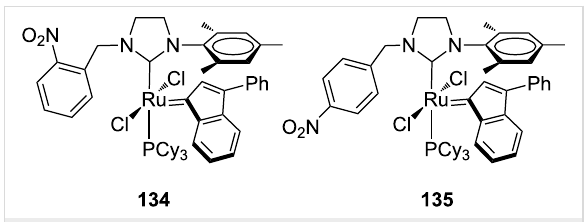
catalysts 120 , 121 , 123 and 124 . A scarce activity toward the formation of tetrasubstituted olefin 12 (Scheme 3) was also ob- served. Complexes 134 and 135 were tested in RCEYM of 127 (Table 5, entry 1) showing a good efficiency and in the CM of 13 and 14 (Table 5, entry 3), where interesting Z -selectivities